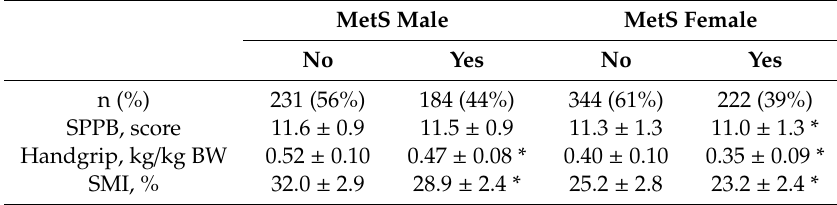
Table 2. Skeletal muscle mass index and physical function in participants with and without MetS. MetS Male MetS Female No Yes No Yes n (%) 231